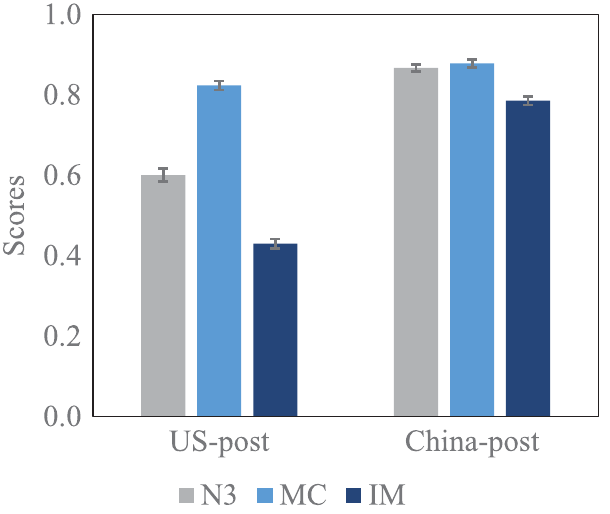
FIG. 5. Post-test performance of U.S. and Chinese students for different concept domains. The error bars represent the standard error of the means.